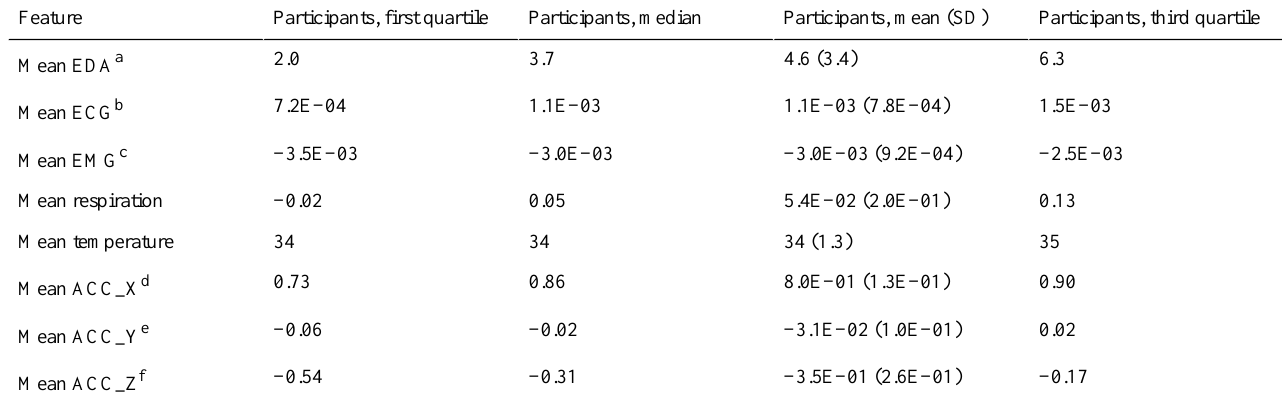
Table 2. Summary statistics of a subset of